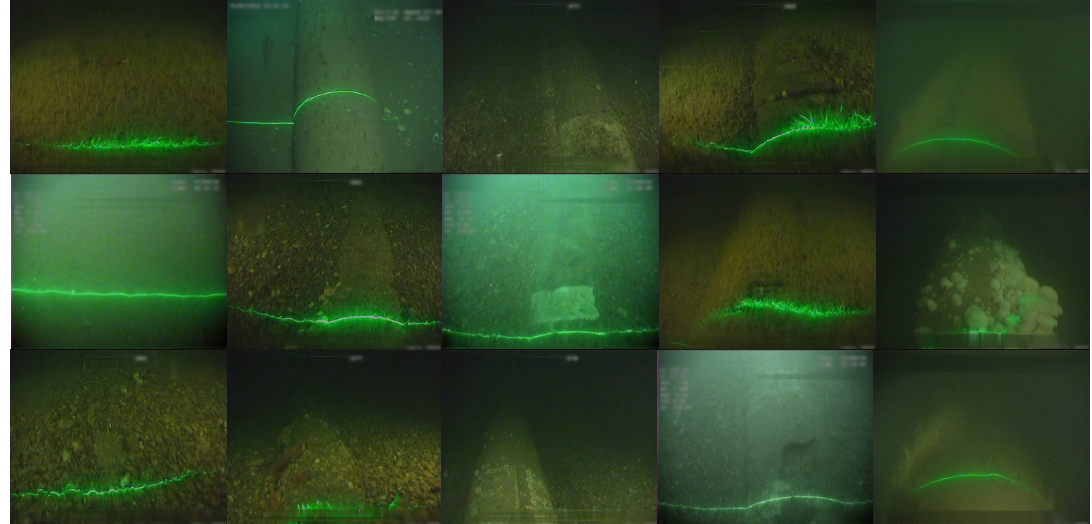
Figure 1. Examples of events in subsea pipeline surveys with varying scene conditions; from left to right: burial, exposure, anode, field joint, free